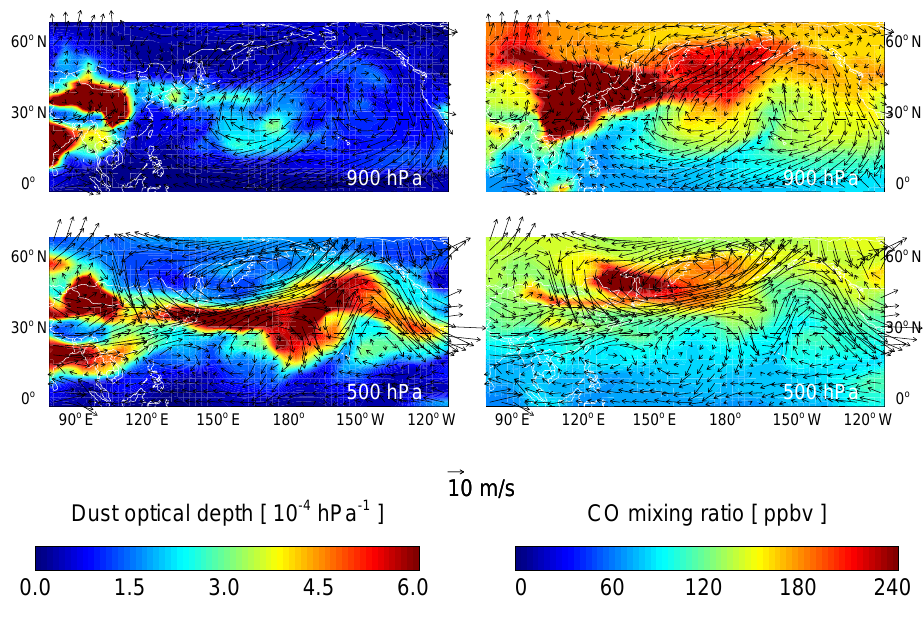
Fig. 8. Wind vectors at 900hPa (first row) and 500hPa (second row) used for model simulation along with the spatial distributions of dust (first column) and CO (second column) during 5–8 May 2003 over the Pacific. The GFED biomass burning emissions are